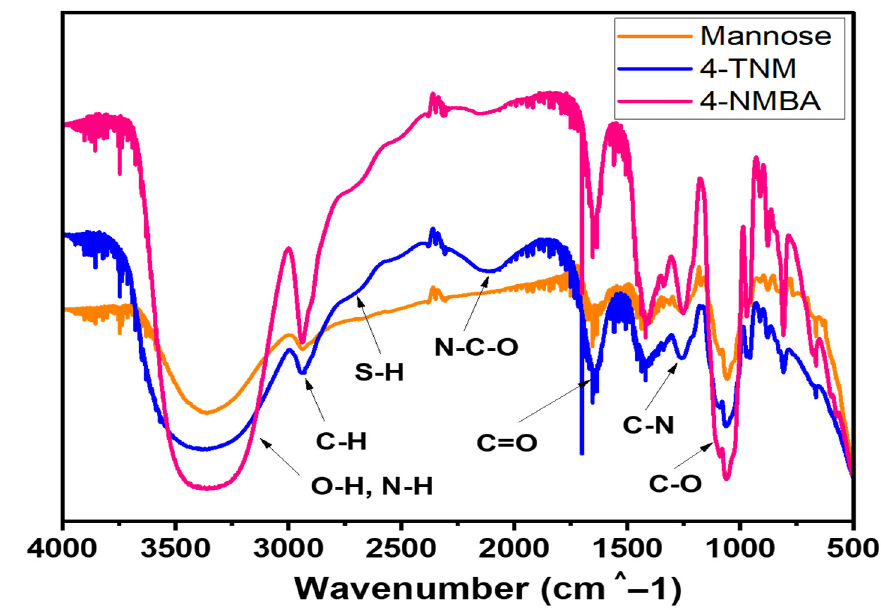
Figure 2. FTIR analysis of mannose and mannose derivatives (4-NMBA and 4-TNM).